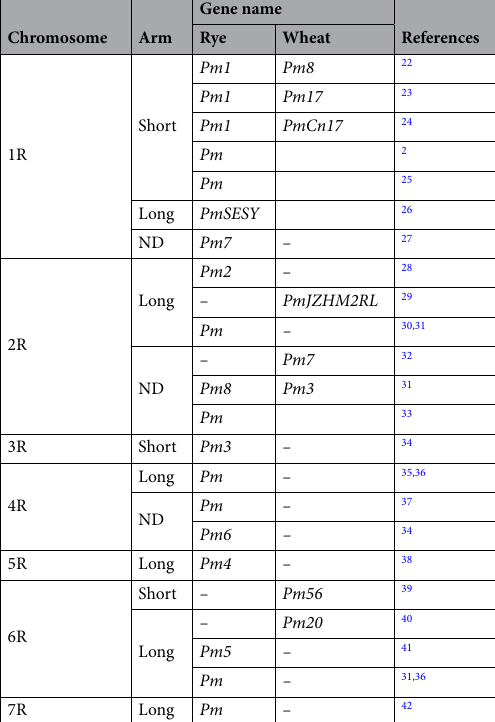
Table 1. Location and origin of powdery mildew resistance genes in rye ( Secale cereale L.) and wheat- ( Triticum aestivum L.) rye translocation lines with rye being the donor parent. After 1–3. . ND: Interchromosomal position not